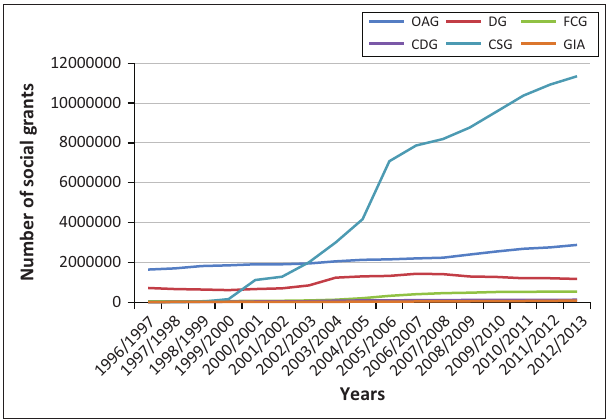
FIGURE 1: Number of social grants since 1996 in south Africa (excl. War Veterans